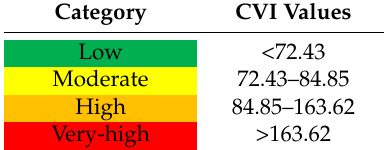
Table 2. Vulnerability categories.